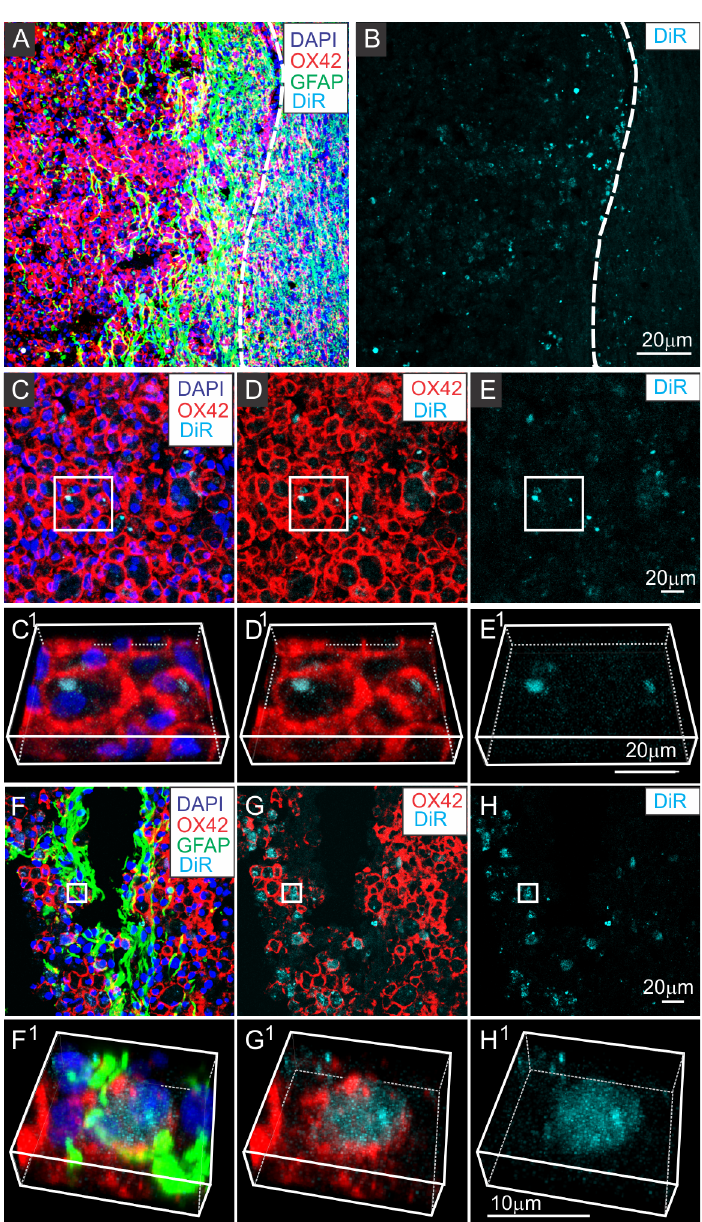
Fig 3. IV infused DiR labeled MSC exos co-localize with OX42 + macrophages/microglia in the contused spinal cord. A-B: Low magnification confocal images of a representative region of a contused spinal cord 3 hours after DiR MSC exos infusion stained for GFAP (green) and OX42 (red) and counterstained with DAPI (blue) (A) or DiR fluorescence only (cyan) (B). Large numbers of DiR hotspots can be seen near the margins of the contusion site correlating with high levels of GFAP + reactive astrocytes (green) and OX42 + macrophages (red). C-E: Higher magnification image of the lesion shown in A showing the relationship between DiR hotspots and OX42 staining. C 1 - E 1 : Enlarged and rotated boxed regions of the lesion shown in C-E showing that the location of DiR hotspots within OX42 + cells. F-H: Representative confocal images of contused spinal cord 24 hours after DiR MSC exos (cyan) infusion shown stained for GFAP (green) and OX42 (red) and counterstained with DAPI (blue), (F), OX42 and DiR (G) or DiR fluorescence only (cyan) (H). F 1 -H 1 : Enlarged and rotated boxed regions of the lesion shown in F-H. All scale bars indicate 20 μ m. Dashed line in A and B indicates the approximate border of the lesion, as defined by the reactive astrocyte boundary, with the lesion to the left and largely intact neural tissue to the right. DiR hot spots appear to be clustered more densely near the borders of the lesioned area, in regions containing both OX42 + macrophages (red) and strongly GFAP + reactive astrocytes (green).